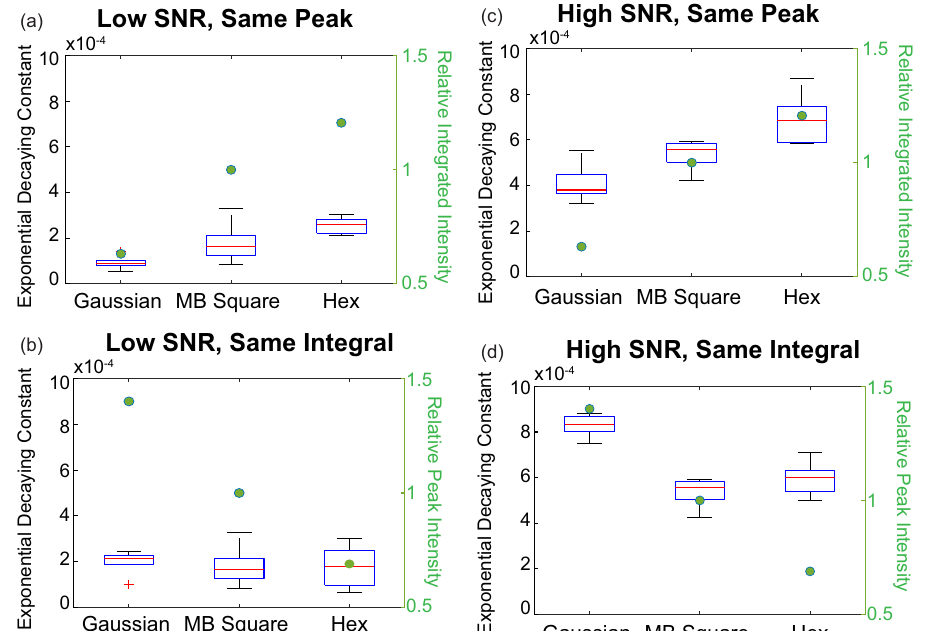
Fig. 5 | Light sheet photobleaching quanti fi cation in live iPSCs. a , b Photobleaching exponential decay constants for iPSC cells expressing fl uor- escently tagged with α -tublin imaged by the three different beams. Five cells are takenforeachcondition.Plotsshowthemedian(redline),the25and75%quantiles (bluebox),datarange(whisker),andoutliers(redcross).Greendotsareplottedon